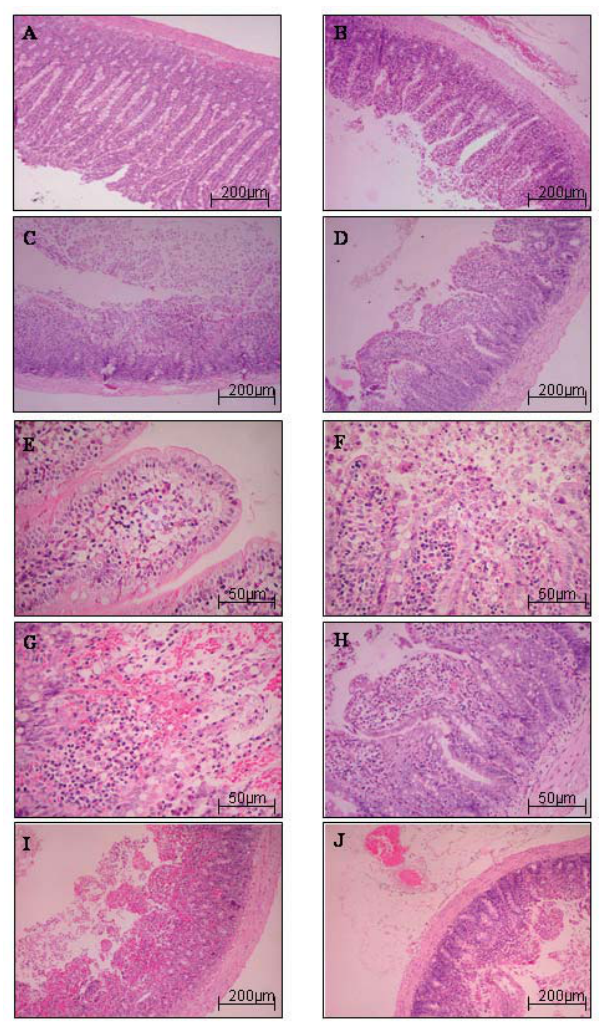
Figure 1. Intestinal architecture of the sham (A), ischemic (B), ischemic/ reperfusion (C) and ischemic/reperfusion/ascorbic acid groups (D), stained with Hematoxilyn and Eosin. Note the maintenance of the architecture of intestine wall in sham group (E). Distortion of the architecture by villous necrosis (F) and decrease of villous (G) are visualized in intestine specimens of animals with ischemia and ischemia reperfusion. In contrast, ischemia/ reperfusion/ascorbic acid treated animals (H) show decrease of villous necrosis and increase in villous cell. Different histoanatomical localization of hemorrhagic infarct was observed for ischemia and ischemia-reperfusion groups. In ischemia groups hemorrhagic infarct was present at the mesenteric border (I) whereas in ischemia-reperfusion groups the antimesenteric border was affected